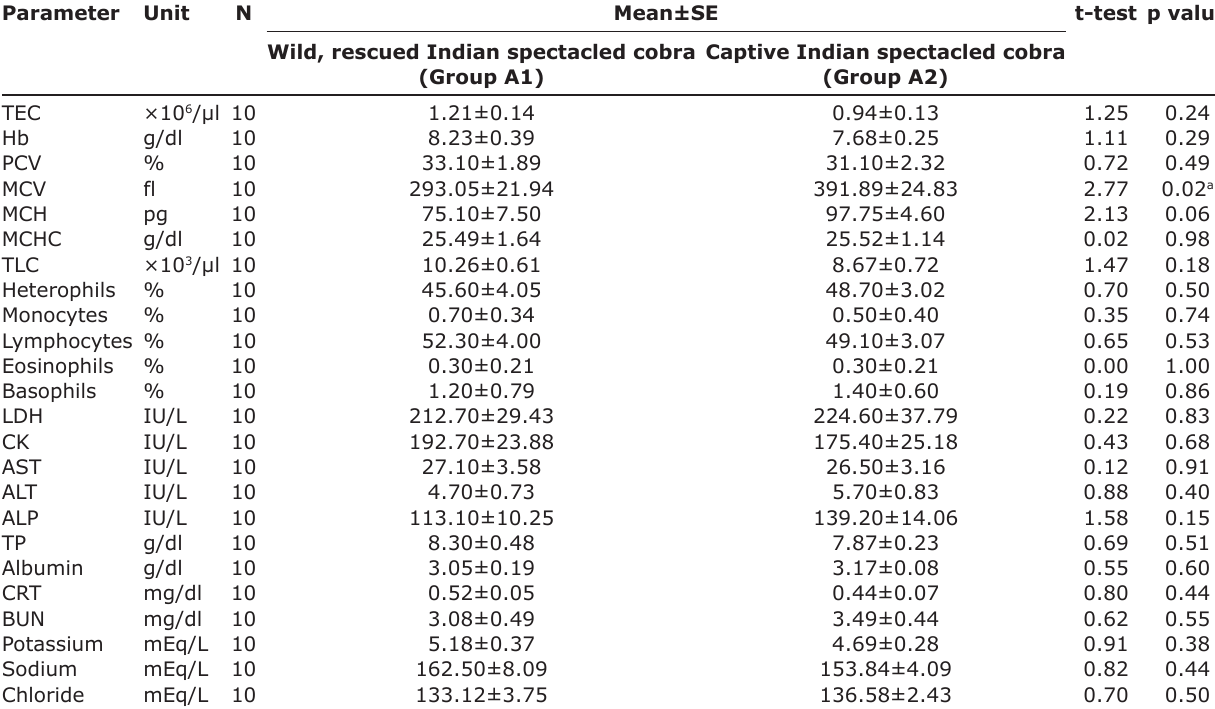
Table-1: Hematology and biochemistry values observed for wild and captive Indian spectacled cobra ( N. naja ) with statistical data. Parameter